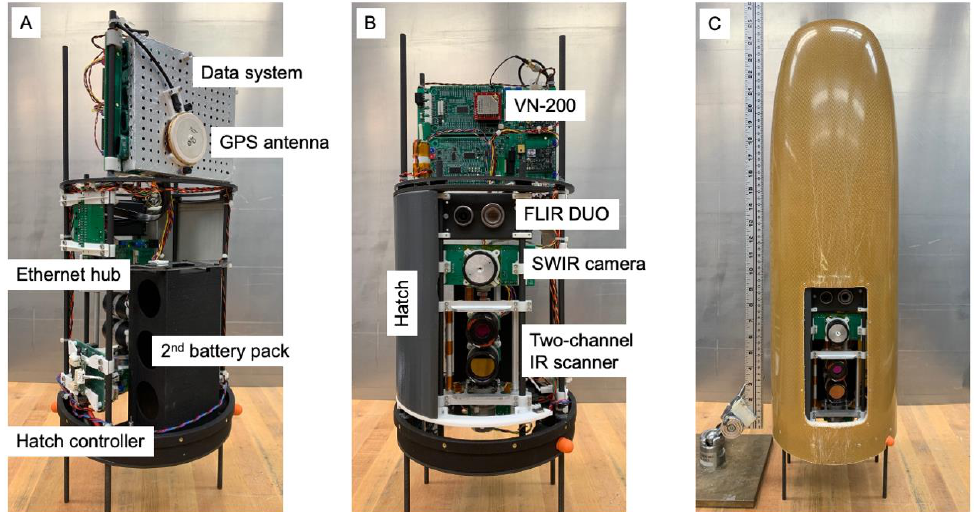
Figure 5. The AWSM sensors integrated into an S2 UAS payload frame. Top ( A ) and bottom ( B ) views of the AWSM system showing the arrangement of the individual sensors and components. Panel ( C ) shows the system inside the S2 nose cone with the hatch open. The hatch is closed before landing to protect the optics from debris.